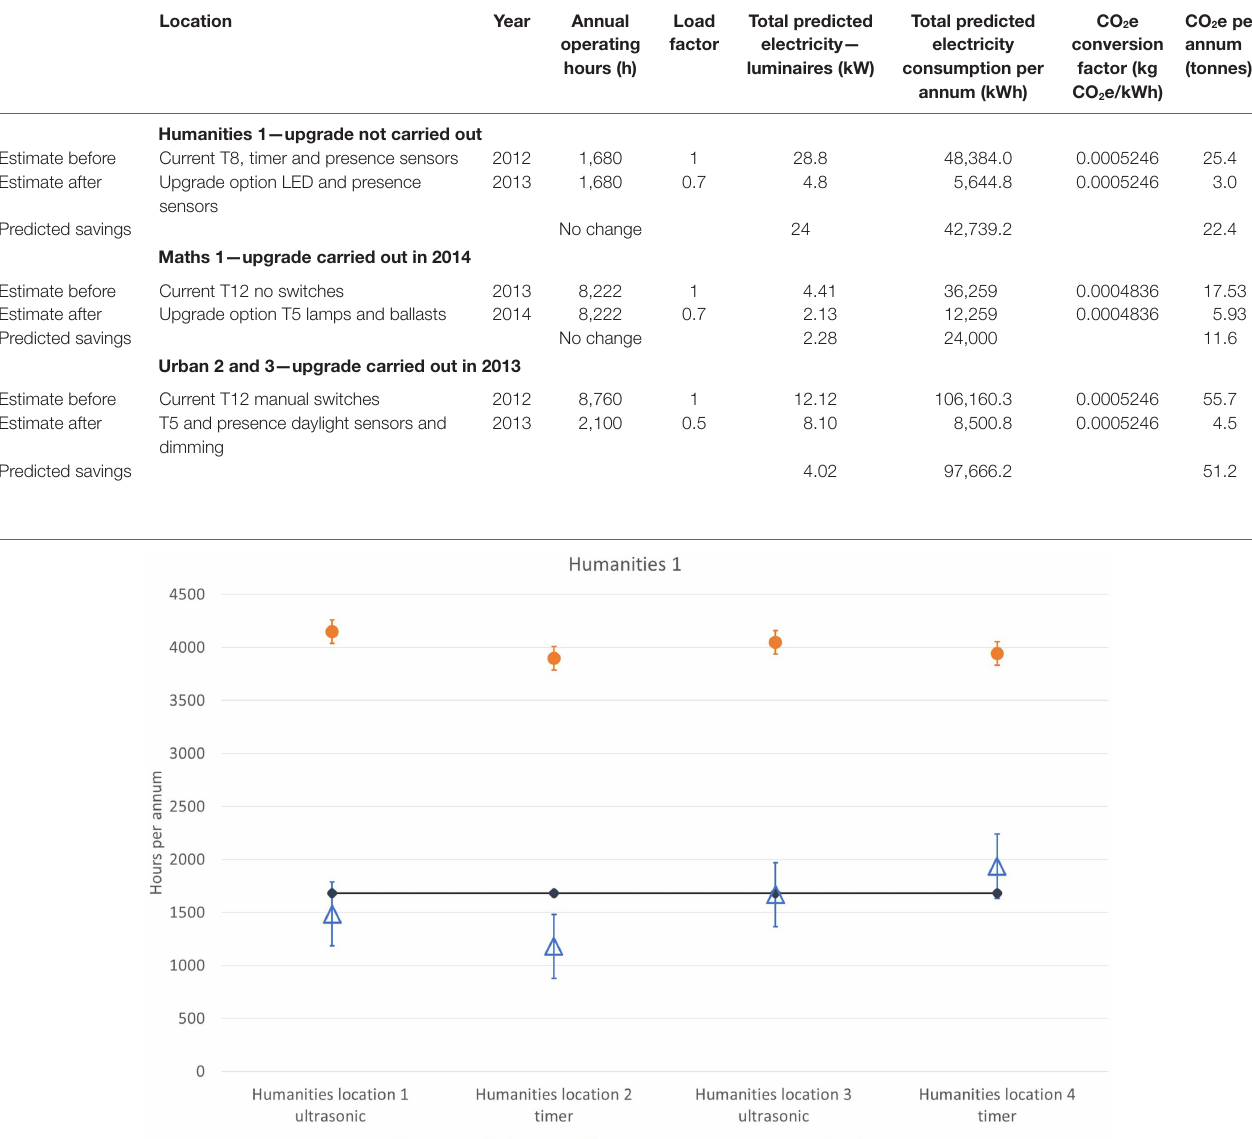
TaBle 2 | Electricity consumption predictions for each